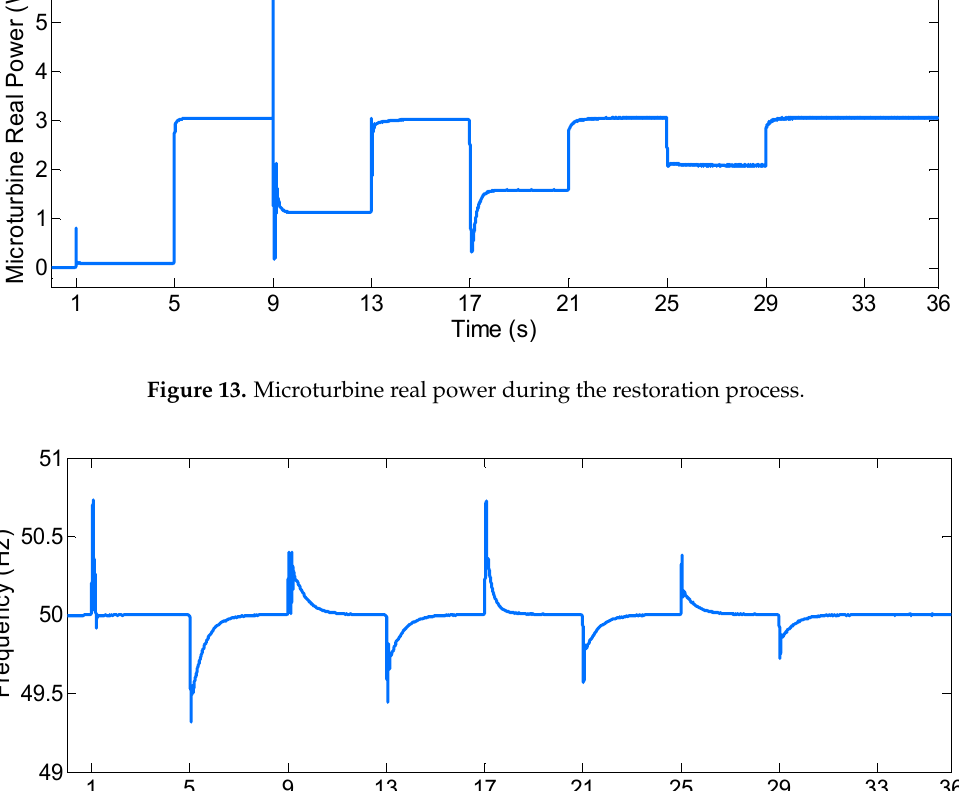
Figure 15. Real power of the microsources. 6. Conclusions This paper proposed a decentralized multi-agent-based approach for MG restoration. In the proposed scheme, the MG local controllers were assigned to specific agents. The communication rule for sharing the local information of the agents and getting access to the global information was based on ACA. A proper restoration decisions strategy based on the discovered global information was developed. Compared to the centralized restoration schemes, the proposed method had the